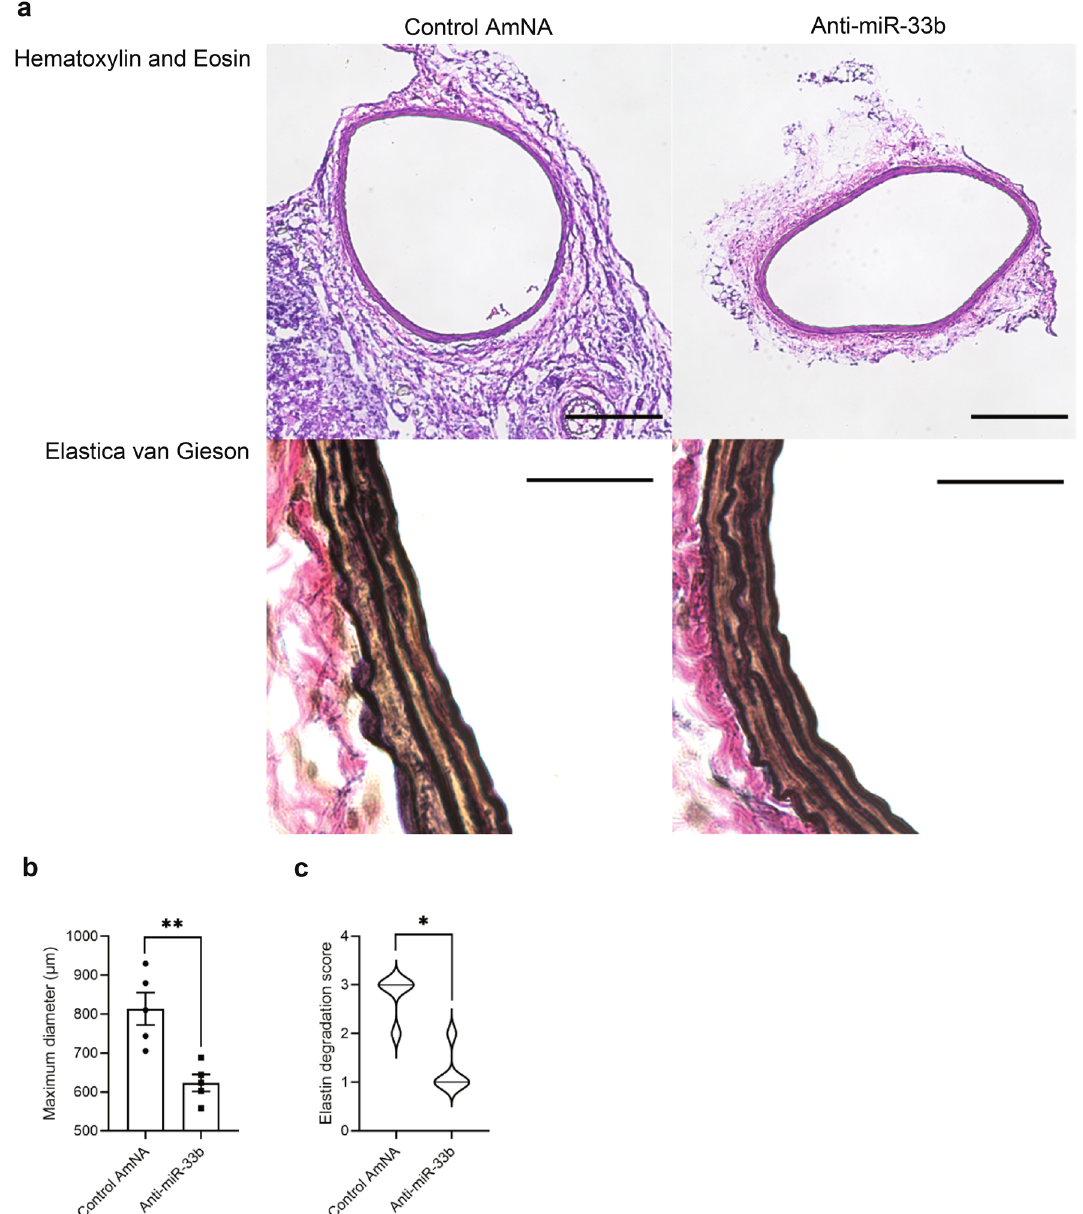
AAA of miR-33b KI mice with administration of the indicated AMOs. Scale bar for HE, 200 µm; for EVG, 20 µm. ( b ) Maximum diameter of CaCl 2 -induced AAA with administration of the indicated AMOs, n = 5 in each group. Unpaired two-tailed t test. **P < 0.01. ( c ) The elastin degradation score of CaCl 2 -induced AAA with administration of the indicated AMOs, n = 5 in each group. Mann–Whitney test. *P < 0.05. All data represent mean ±